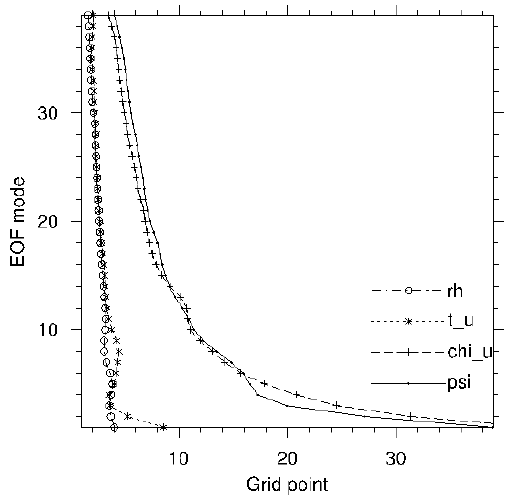
Figure 10. Vertical length scale for CV5 (WRF, res. 15km, D- ensemble,